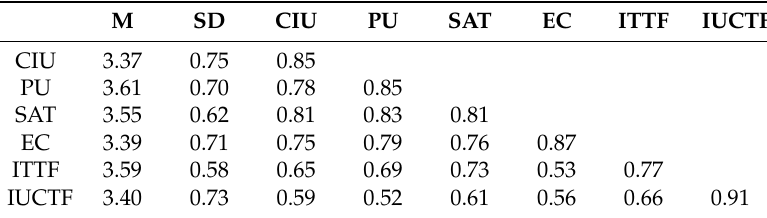
Table 6. Discriminant validity for each pairwise of